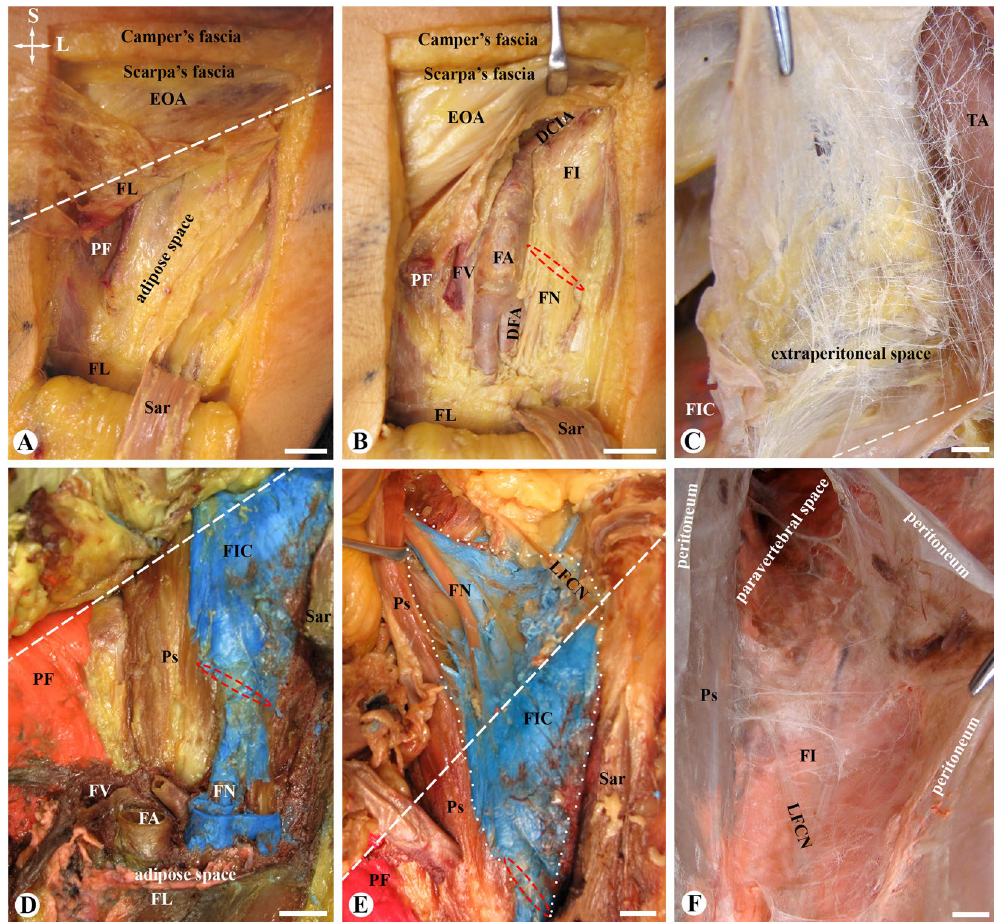
Figure 1. A layer-by-layer dissection ( A , B ) and latex injection ( C–F ) in the femoral triangle. ( A ) The adipose space underneath the fascia lata (FL) and sartorius (Sar; reflected inferiorly). EOA: external oblique abdominis; PF: pectineal fascia. ( B ) The femoral nerve (FN) pierces the fascia iliaca (FI) via the inferior opening (red dashed circle) of the fascia iliaca compartment (FIC). DCIA: deep circumflex iliac artery; DFA: deep femoral artery; FA: femoral artery; FV: femoral vein. ( C ) Single-coloured latex injected underneath the fascia iliaca, showing latex spread in the FIC but not in the extraperitoneal space between the transverse abdominis (TA) and peritoneum (held by forceps). D and E: Coloured Latex injected underneath the fascia lata (pink), fascia iliaca (blue) and pectineal fascia (red) prior to fascia dissection. Pink latex spreads in the adipose space superficial and lateral to the femoral artery (FA) and vein (FV). Blue latex (about 20 mls) fills in the FIC (white dotted curves) and spreads through its inferior opening (red dashed circle). F: Single-coloured latex (more than 30 mls) injected underneath the fascia iliaca (FI), showing latex spread in the FIC and paravertebral space. Dashed lines: level of the inguinal ligament; Ps: psoas; Ili: iliacus; LFCN: lateral femoral cutaneous nerve; Crossed-arrows: orientation of the figure (L: lateral; S: superior); Bars = 10